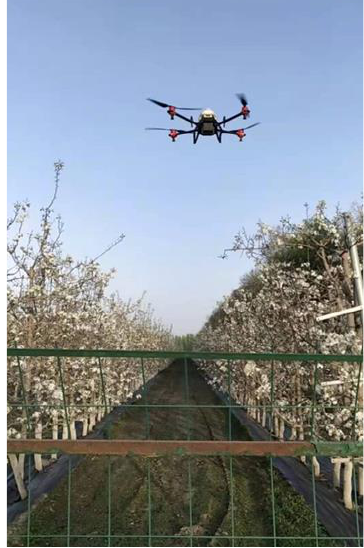
Figure 2. UAV pollination field test.